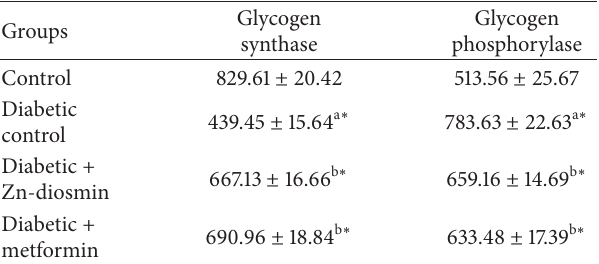
Table 5: The activities of glycogen synthase and glycogen phospho- rylase in liver tissues of control and experimental groups of rats.